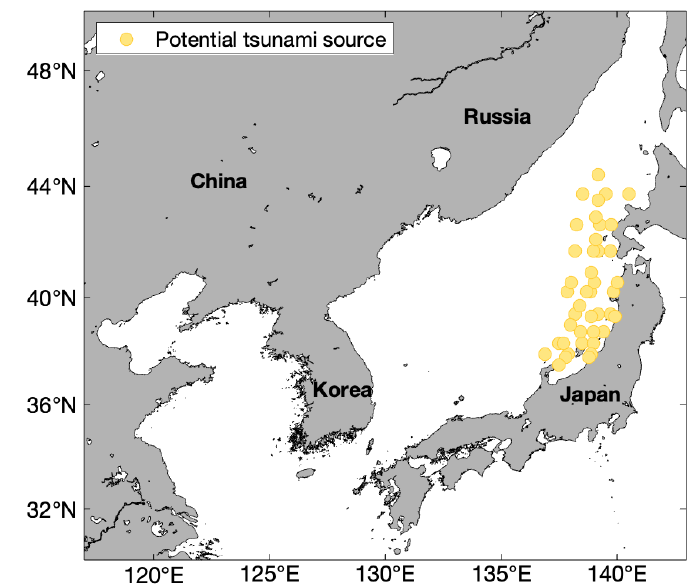
Appl. Sci. 2020 , 10 , x FOR PEER REVIEW Figure 1. The location of 39 potential tsunami sources near the west coast of Japan.